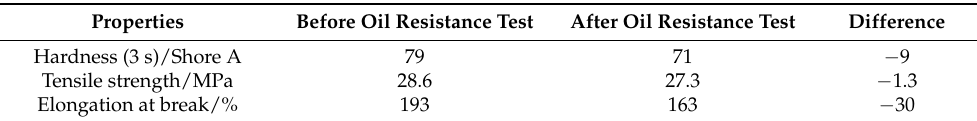
Table 4. Mechanical performance of the HXNBR compound before and after the oil resistance test of IRM 903 standard